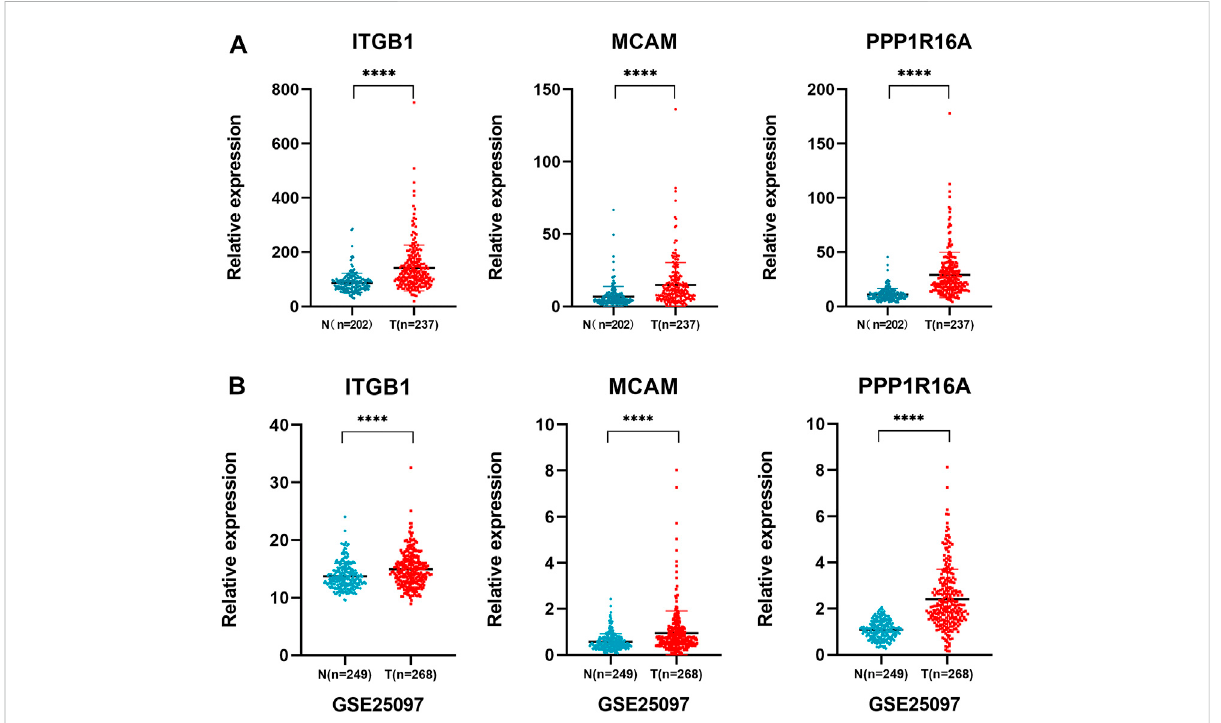
FIGURE 6 Validation of the 3-gene signature in independent cohorts. (A) LIRI-JP dataset was used to validate the expression of ITGB1 , MCAM , and PPP1R16A innon-tumoralandtumorallivertissuesamples.Independentstudent ’ s t -test,****, p < 0.0001; (B) validationofthethreegeneexpressions in an independent cohort GSE25097